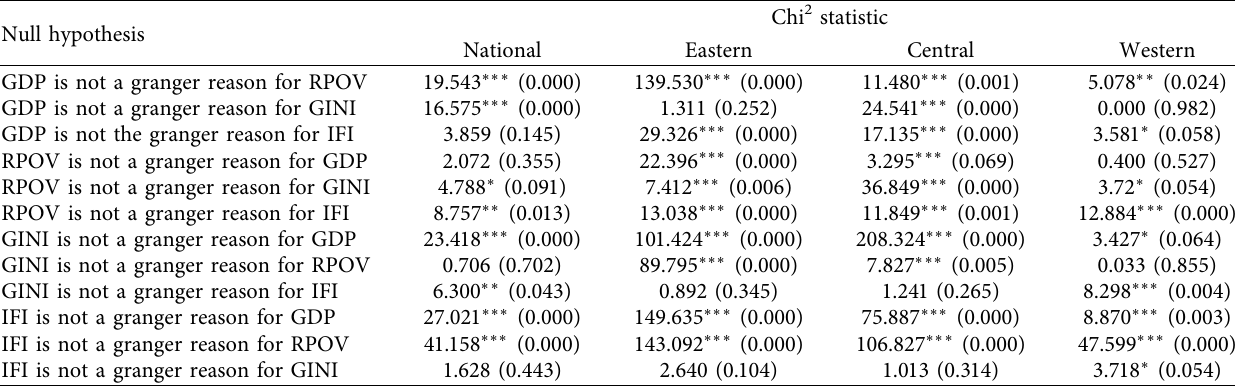
Table 4: Panel granger causality